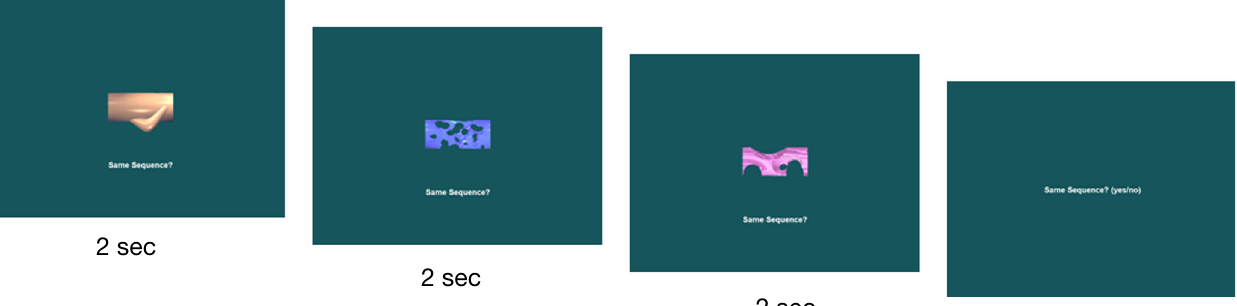
Figure 5 | A sample manipulated sequential relations test trial based on Figure 2. This is the only type of test trial in which the three stimuli were presented sequentially rather than simultaneously.